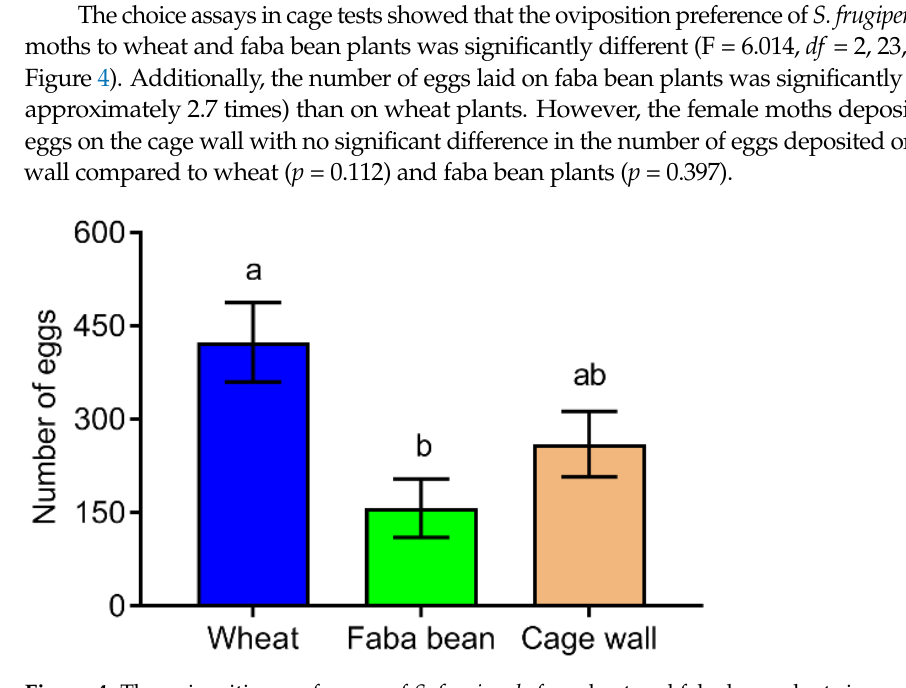
Figure 3. The relative water ( A ), soluble sugar ( B ), total protein ( C ), total phenol ( D ), and tannin contents ( E ) in wheat and faba bean leaves. All data are presented as the mean ± standard error (SE). The value bars with “ns” are not significant; “**” on the top of standard error bars indicate a significant difference between two host species (independent sample t -tests, p < 0.01).